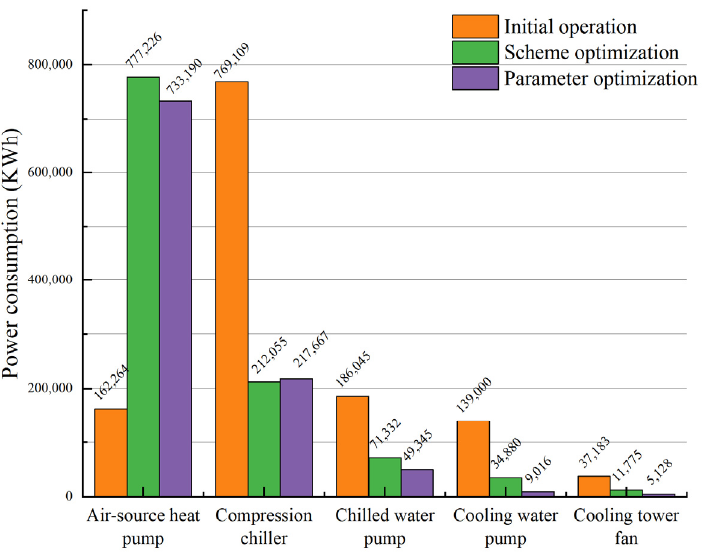
Figure 14. Energy consumption of the equipment under different optimized strategies.